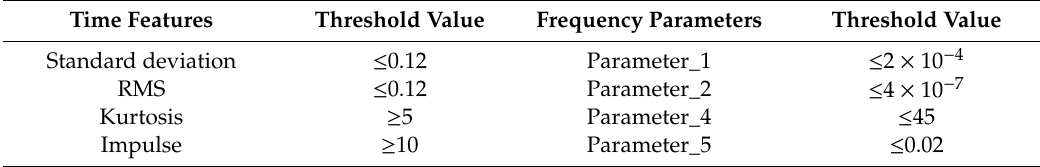
Table 3. Threshold values for identifying a gear set with a fault in binary classification.